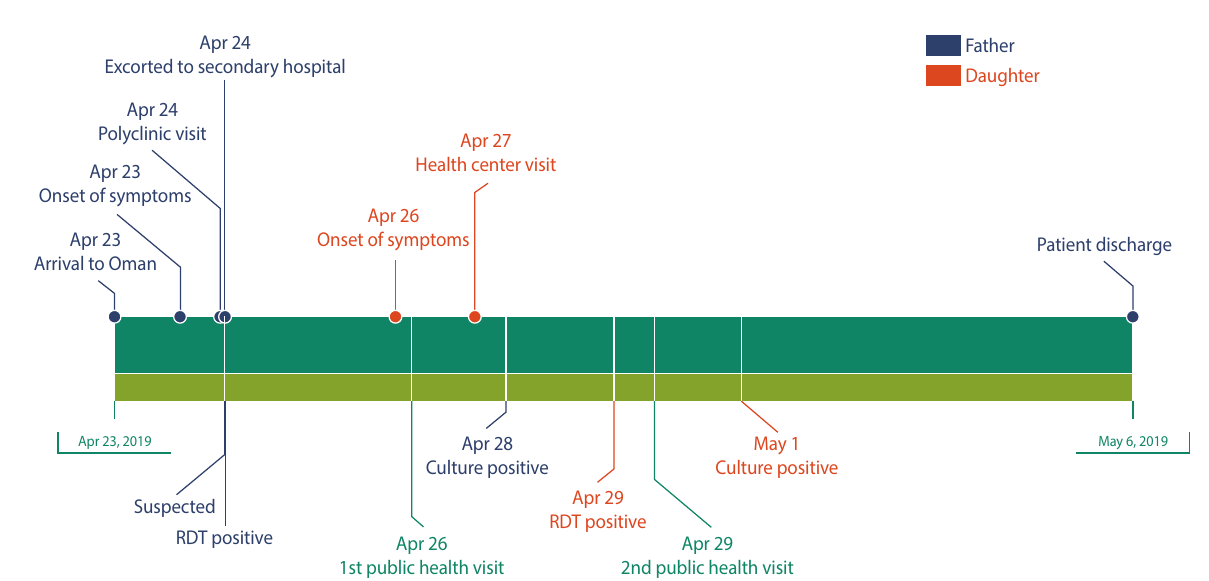
Figure 1. Timeline of patients' clinical progress, tests performed and management. RDT, rapid diagnostic